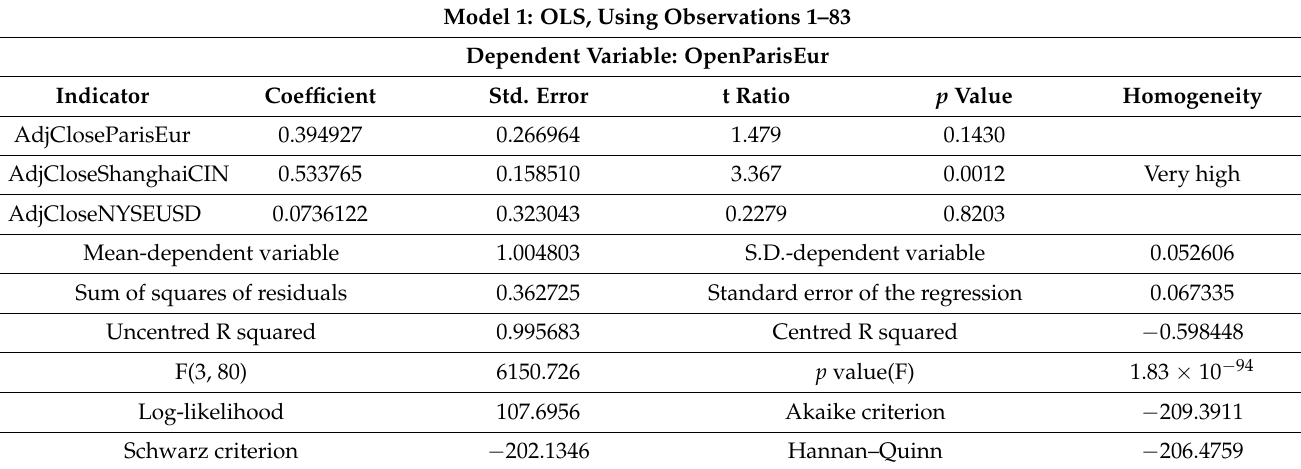
Table 2. Summary of the European volatility matrix model.